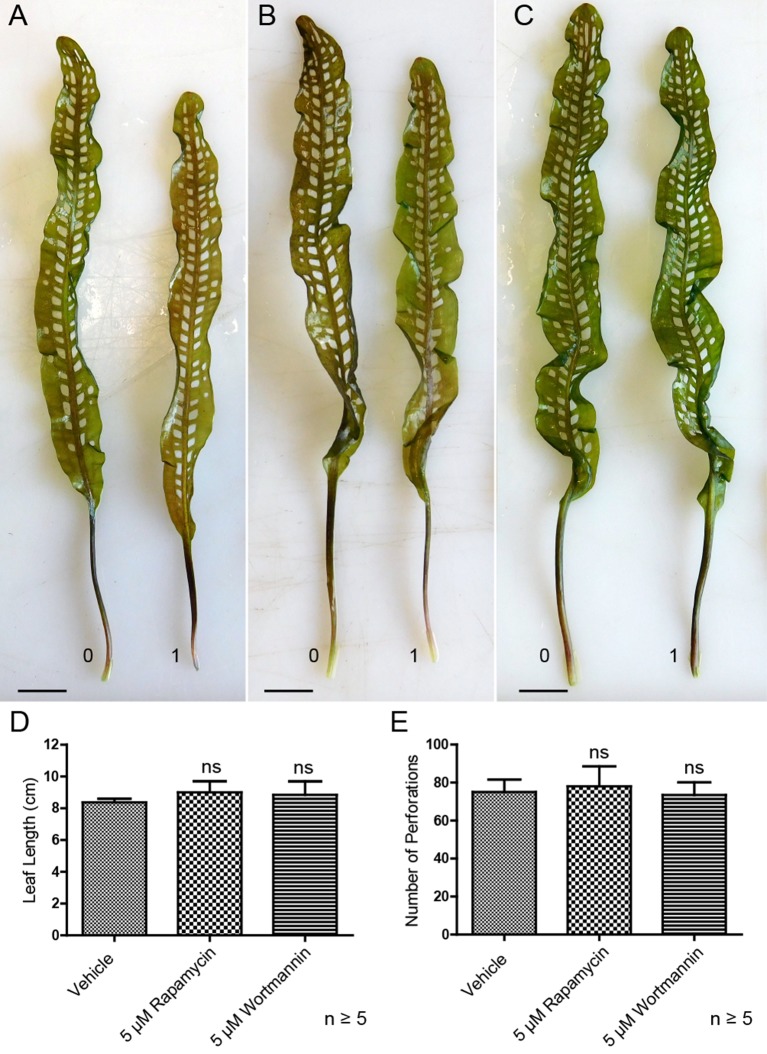
Autophagy modulation in vivo. Representative leaves for the DMSO control (A), 5 µM rapamycin (B), and 5 µM wortmannin (C) treatment groups. Leaf 0 represents the last to develop prior to treatment application, and leaf 1 is the first to develop afterward. (D) Mean leaf lengths of mature leaves posttreatment. (E) The number of perforations in mature leaves following treatment. One-way analysis of variance, Dunnett multiple-comparisons test, n ≥ 5 plants, ns = non-significant, P > 0.05). Error bars represent standard error. Scale bars: 0.5 cm.